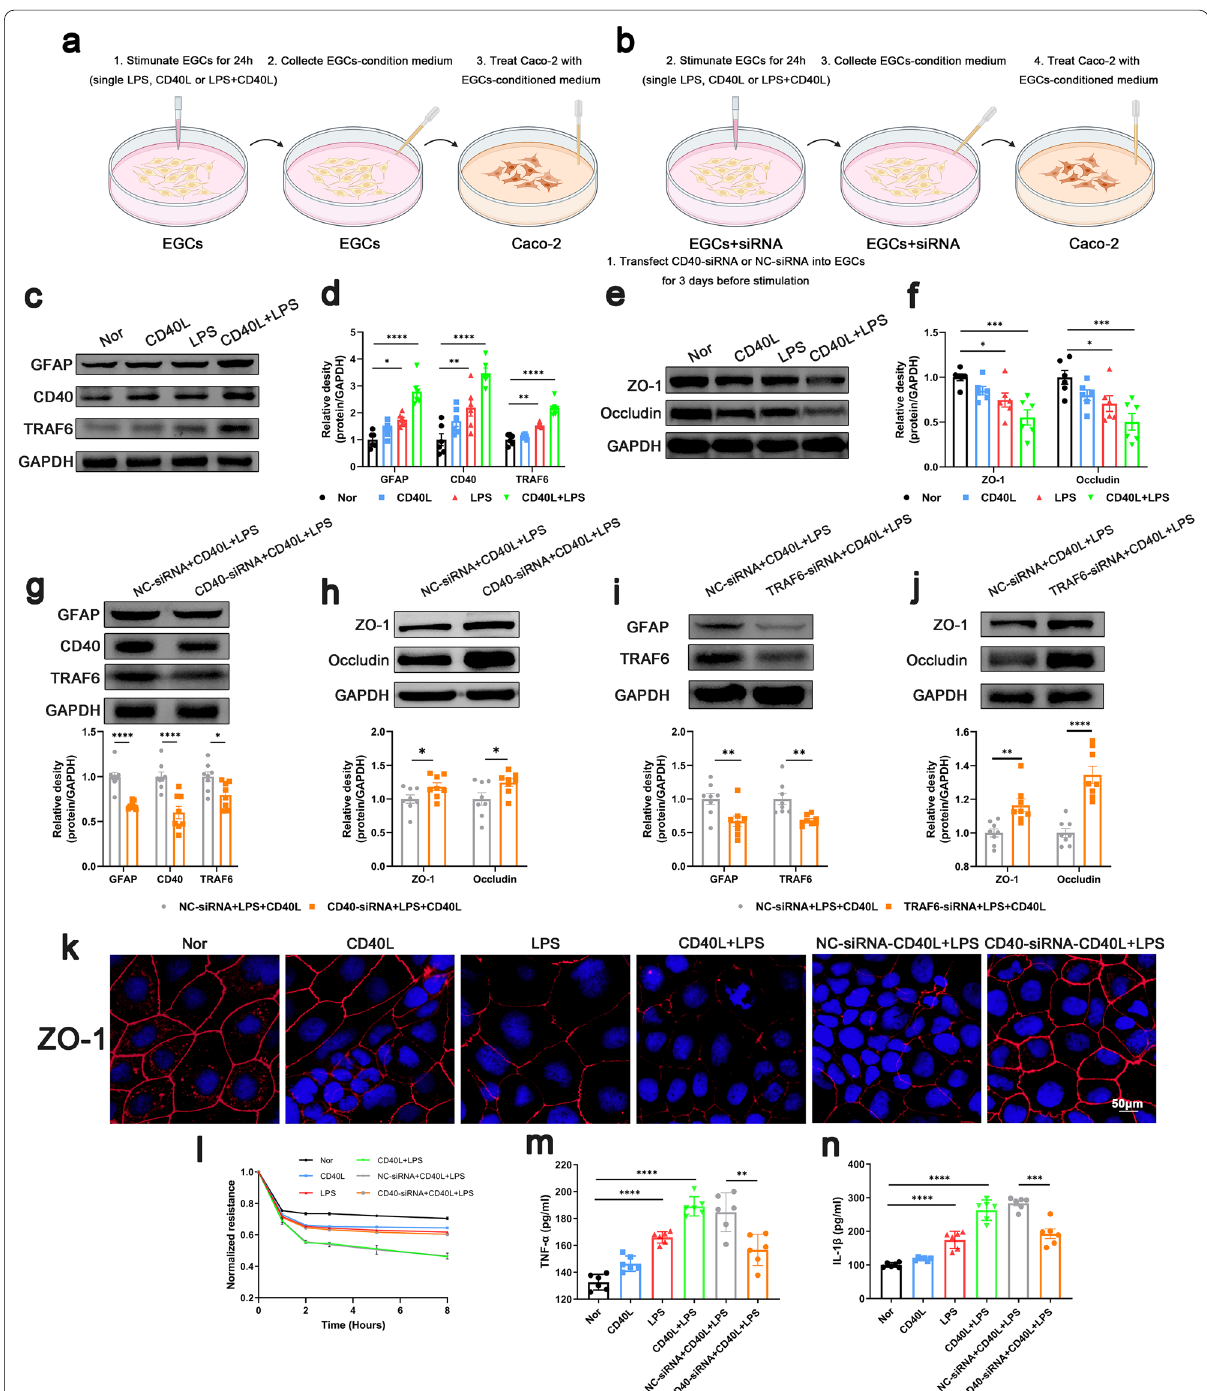
Fig. 4 Effect of CD40L-CD40-TRAF6 signaling on EGCs in vitro. a , b Primary EGCs were stimulated with LPS, CD40L alone or LPS siRNA transfection and the EGCs-conditioned medium were collected for Caco-2 culture. Western blot analysis of GFAP, CD40 and TRAF6 expression in EGCs ( c , d , g , i ), ZO-1 and occludin expression in Caco-2 cells ( e , f , h , j ) (n 6). k Immunofluorescence staining analysis of ZO-1 (red), Scale = bar 50 μm. l Transepithelial electrical resistance (n 3). TNF-α ( m ) and IL-1β ( n ) levels in EGCs-conditioned medium (n = = as the mean SEM, * P < 0.05, ** P < 0.01, *** P < 0.001, **** P < ±